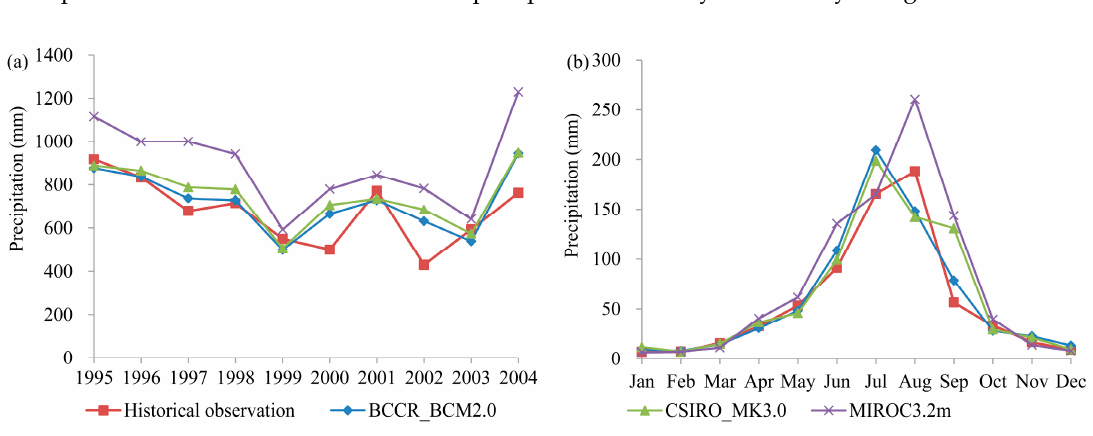
Figure 7. Comparison of the downscaled precipitation from CMIP3 using morphing and historical observation precipitation series: ( a ) annual series; ( b ) monthly distribution.